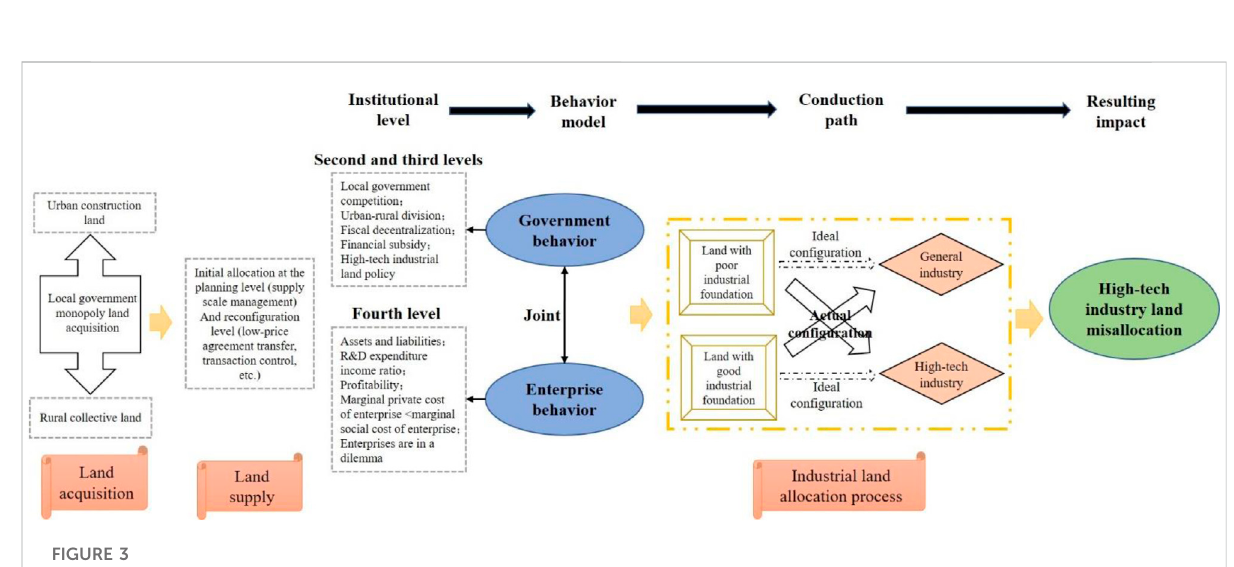
FIGURE 3 Theoretical analysis framework for land misallocation in the high-tech